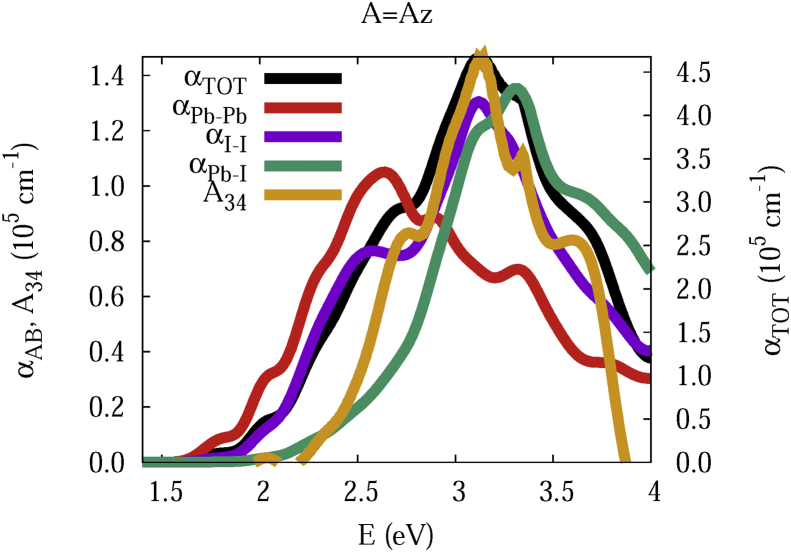
Same legend as that in Fig. 1, but for A = Az.